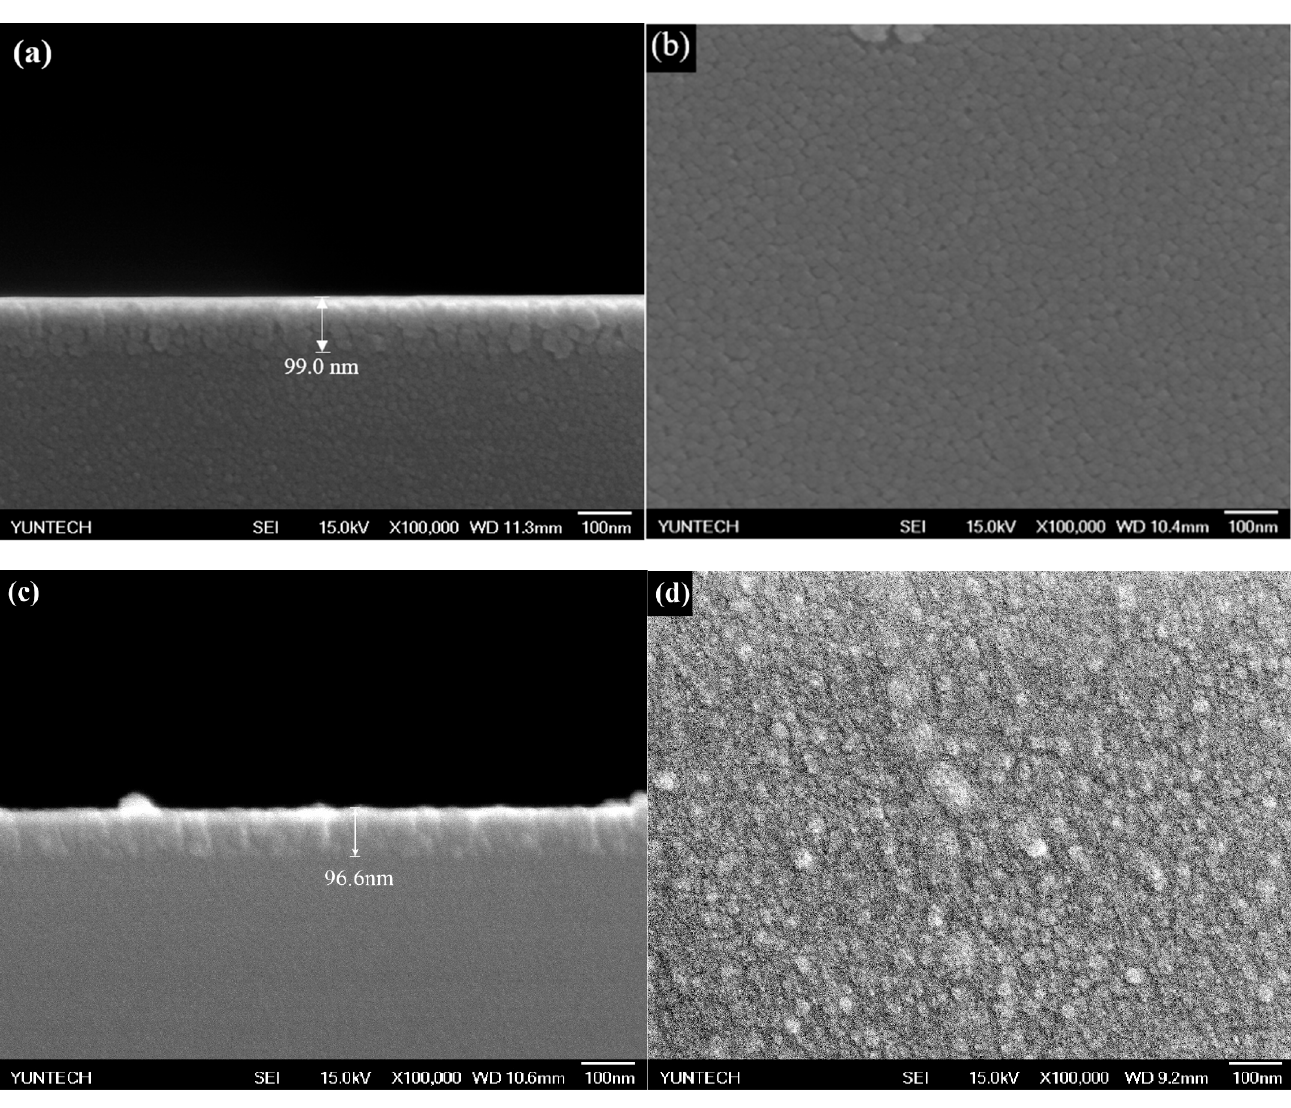
Figure 3. The FE-SEM cross-section images of ( a ) ZnO and ( c ) AZO films, and the FE-SEM top view images of ( b ) ZnO and ( d ) AZO films.